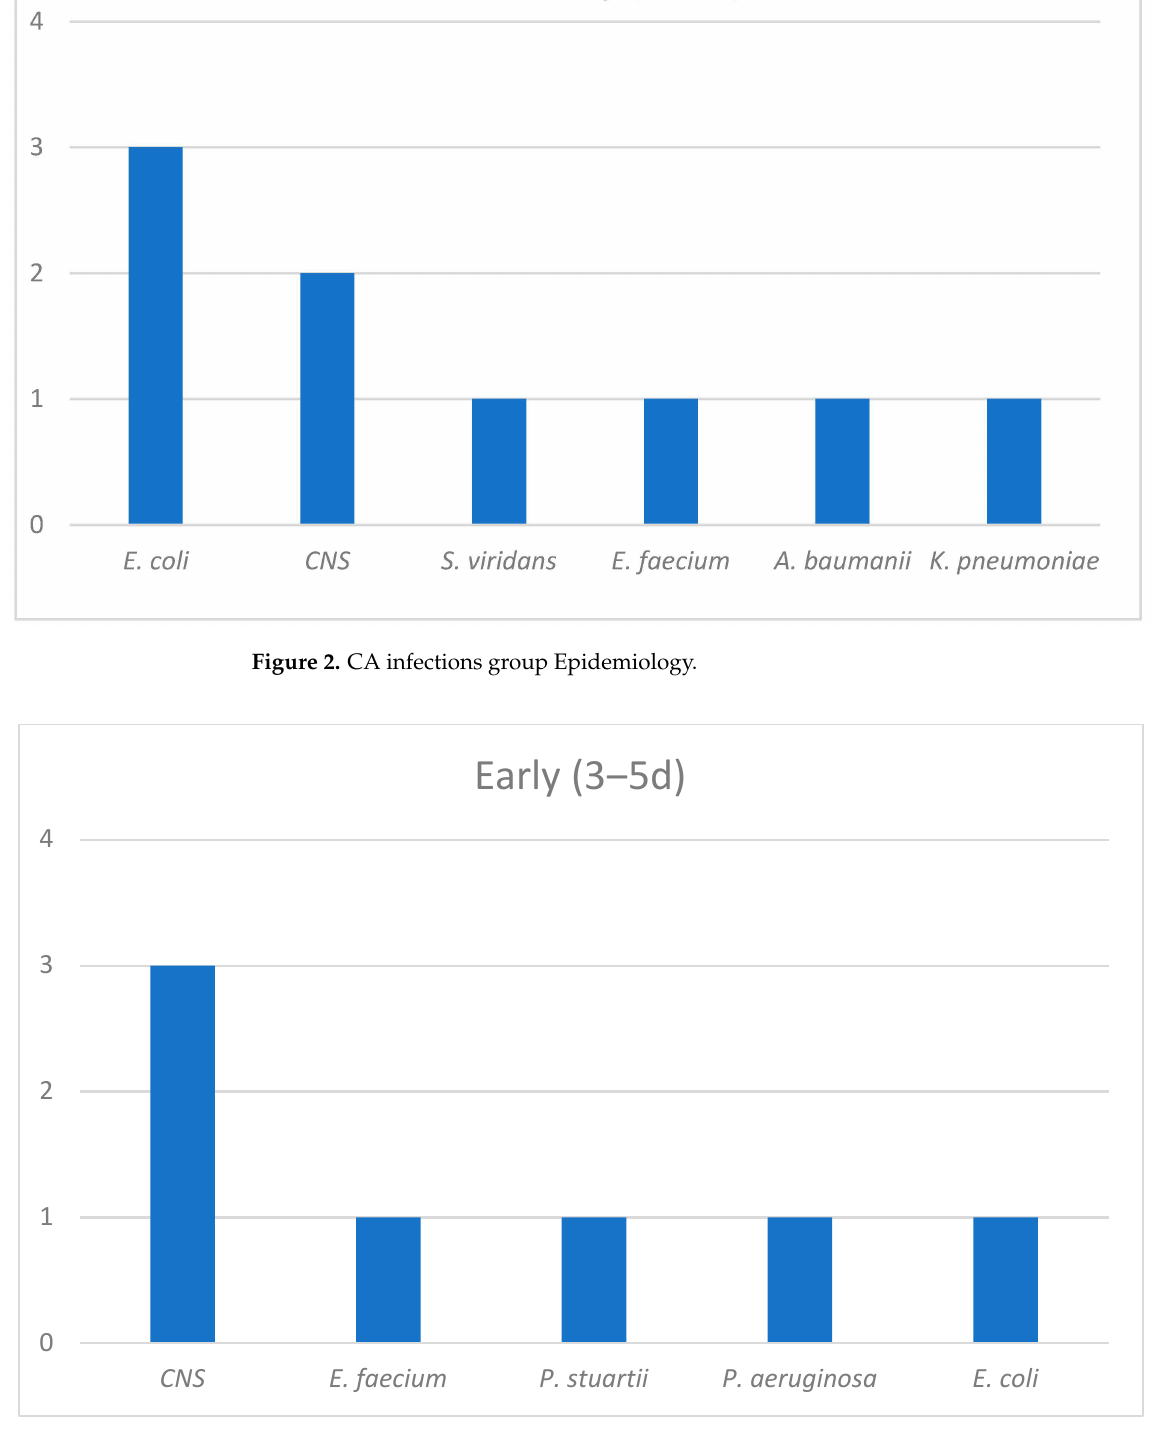
Figure 3. EHA infections group epidemiology